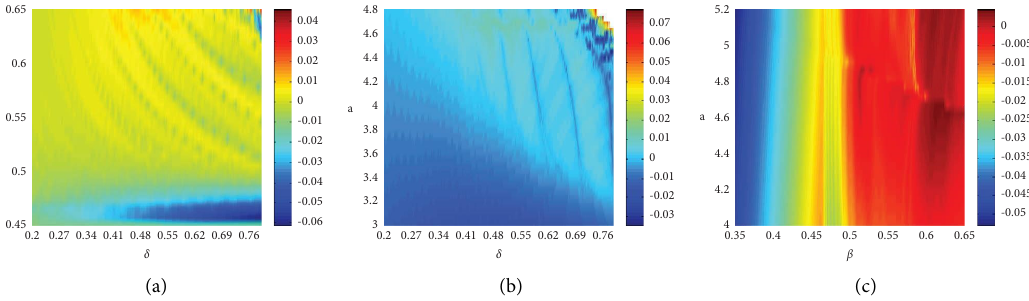
Figure 8: Dynamics of system (4) in 2D parameter space. Te 2D projection of 3D MLEs onto (a) ( δ , β ) plane, (b) ( δ , a ) plane, and (c) ( δ , β )